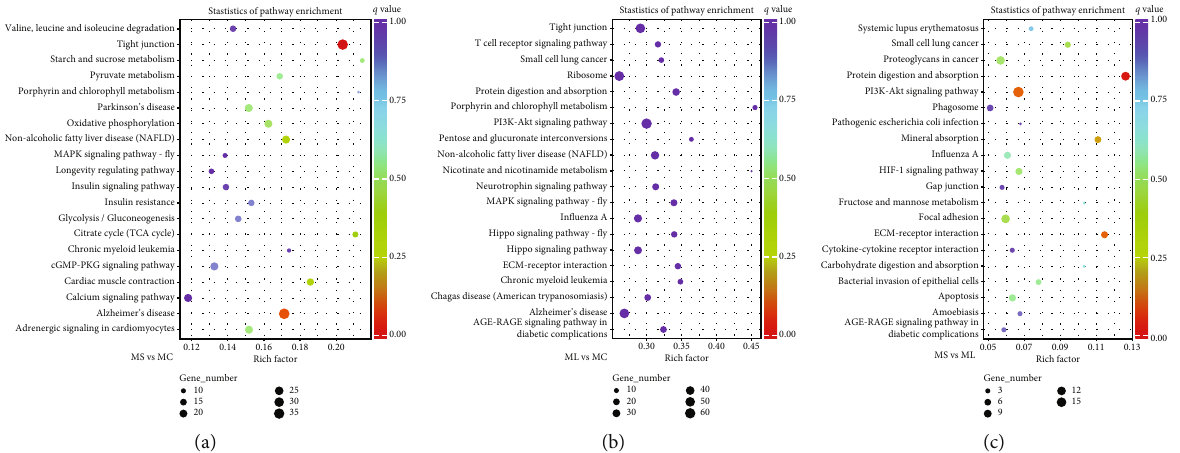
Figure 8: Kyoto encyclopedia of genes and genomes (KEGG) pathway enrichment analysis of DEGs in Synechogobius hasta muscle (Top 20). Representative top 20 pathways of DEGs identi fi ed in the comparison of MS vs . MC (a), ML vs . MC (b), and MS vs . ML (c). The horizontal axis denotes the ratio of DEGs with a speci fi c pathway term relative to all DEGs. The vertical axis represents the annotated KEGG pathway term. The size and color of the bubbles represent the number of DEGs with a speci fi c KEGG pathway and the enriched signi fi cance, respectively. MC: muscle in the control group (continuously fed for 14 days); MS: muscle in the starved group (starved for 3 days); ML: muscle in the starved group (starved for 14